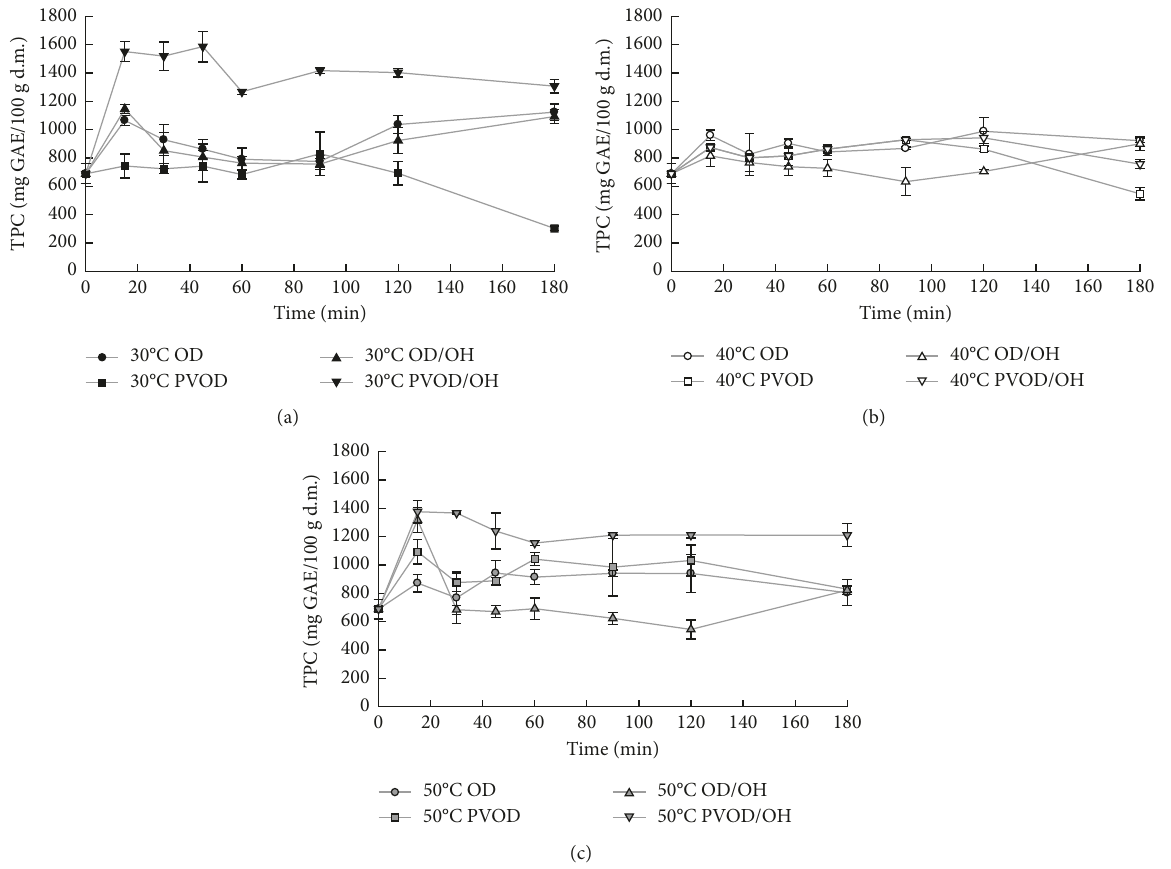
Figure 2: Total phenolic content (TPC) kinetics of osmodehydrated apple using cryoconcentrated pomegranate juice (47 ° Brix) for 180min. OD: osmotic dehydration at atmospheric pressure; PVOD: osmotic dehydration with pulsed vacuum; OH: ohmic heating (OD/OH and PVOD/OH) at 6.66V/cm. (a) 30 ° C; (b) 40 ° C; (c) 50 ° C.